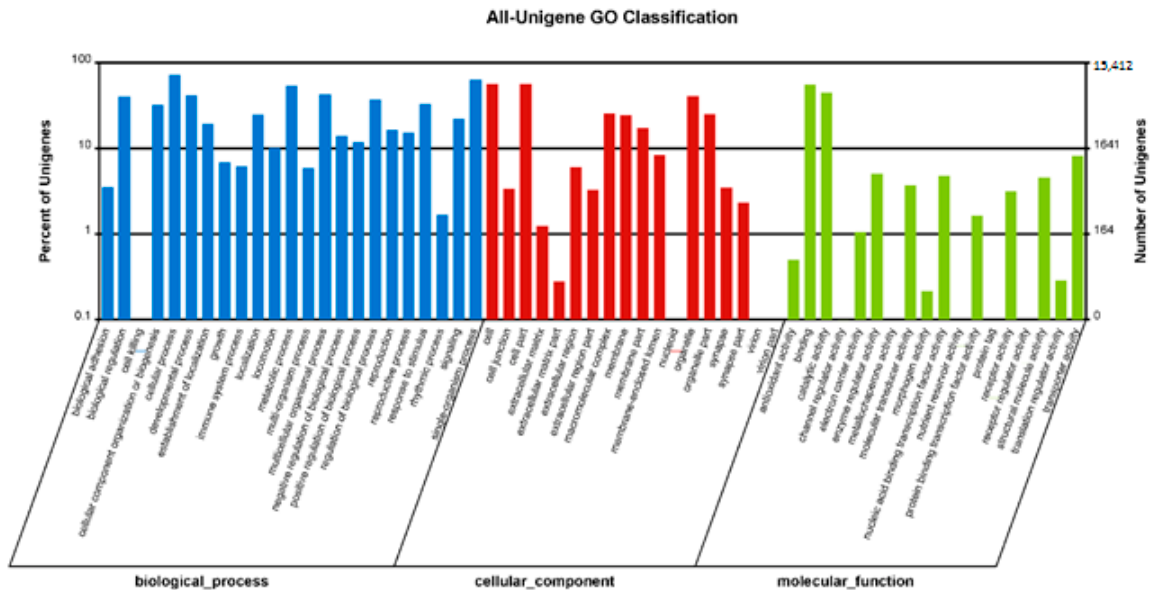
Figure 2. Classification of the clusters of orthologous groups (COG) for the transcriptome.